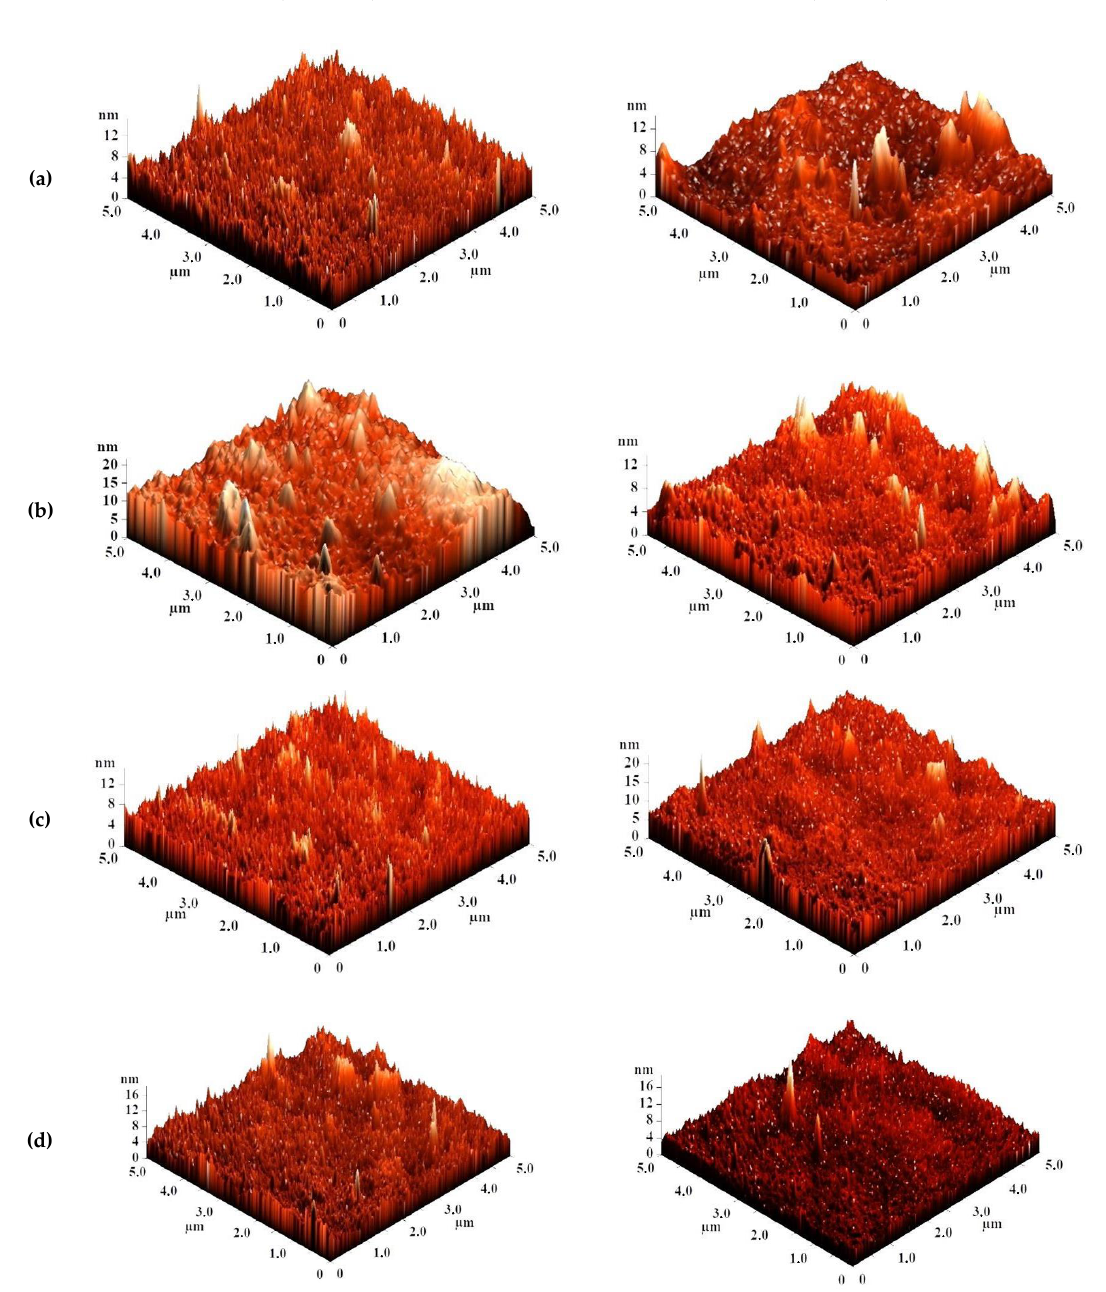
Figure 7. AFM images of TFC membranes ( a ) CS/PAN-2, ( b ) CS/PAN-3, ( c ) CS/PAN-4, ( d ) CS/PAN-5 without and with polyamide layer formed by IP.